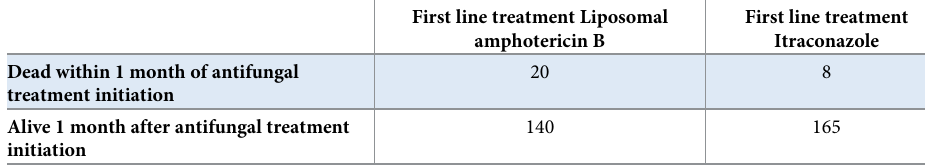
Table 3. Death within one month by first line antifungal treatment choice.